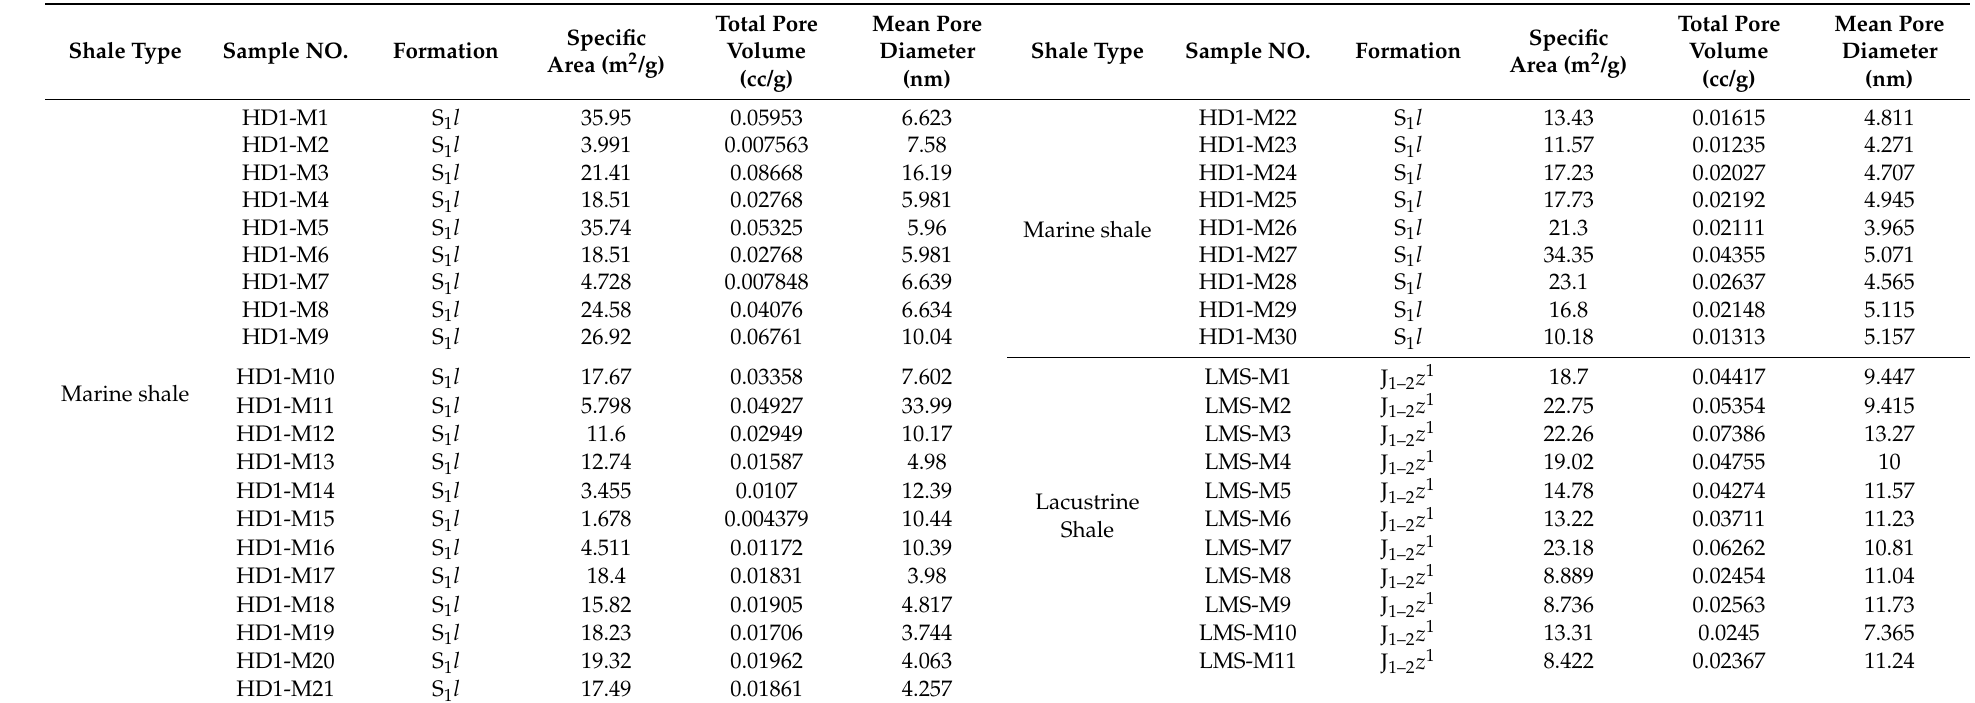
Table 2. The N 2 adsorption test